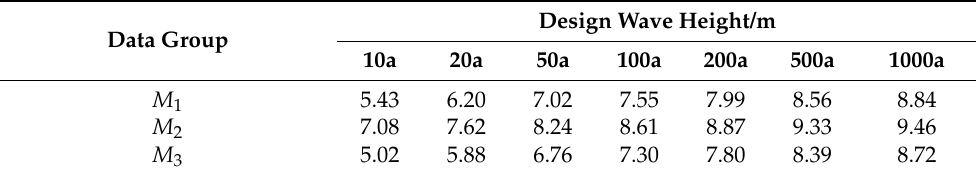
Table 8. Design wave height.